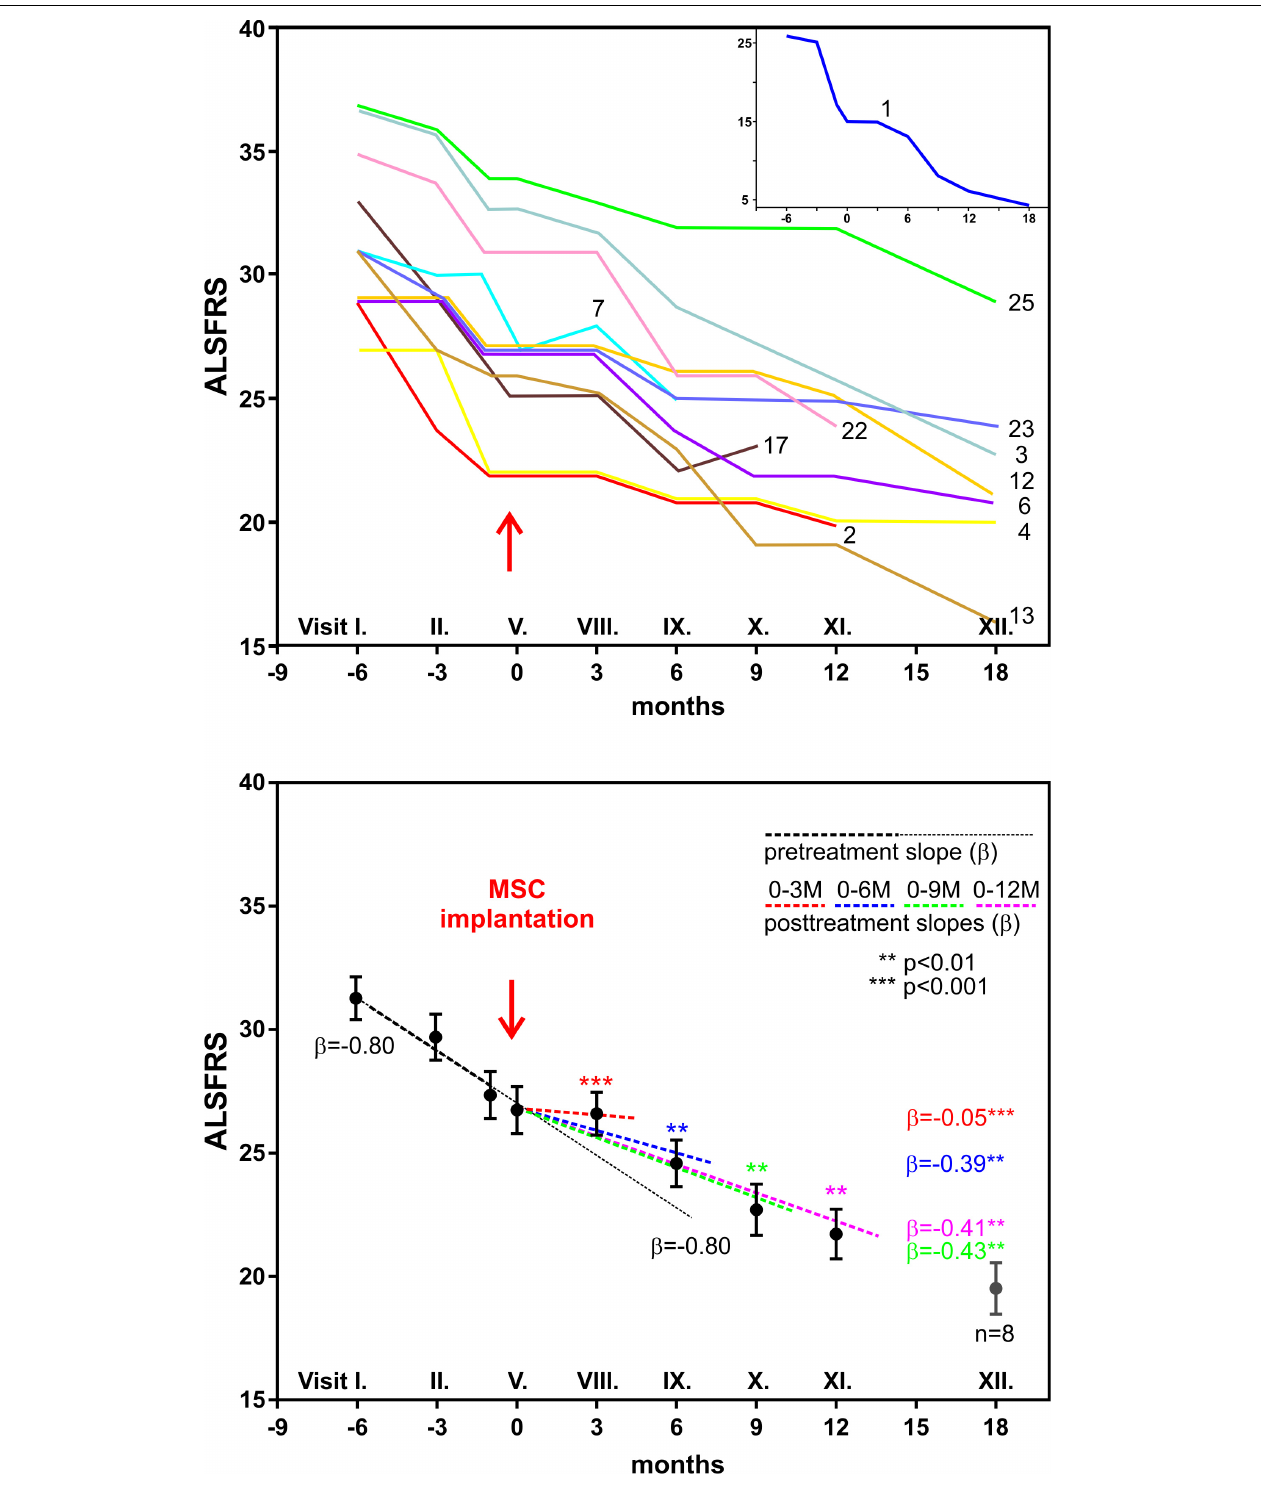
FIGURE 5 | Clinical analysis of 12 amyotrophic lateral sclerosis patients with fast decline of functional rating scale (ALSFRS) scores 6 months before and 12 months after autologous bone marrow mesenchymal stem cell (BMSC) application. The upper panel shows the time courses of ALSFRS scores in individual patients; patient no. 1 is shown in the inset. The lower panel shows the regression analysis of ALSFRS scores before and after BMSC application. The solid line with β = –0.80 is the predicted time course without BMSC treatment. Modified from Sykova et al. (2017).